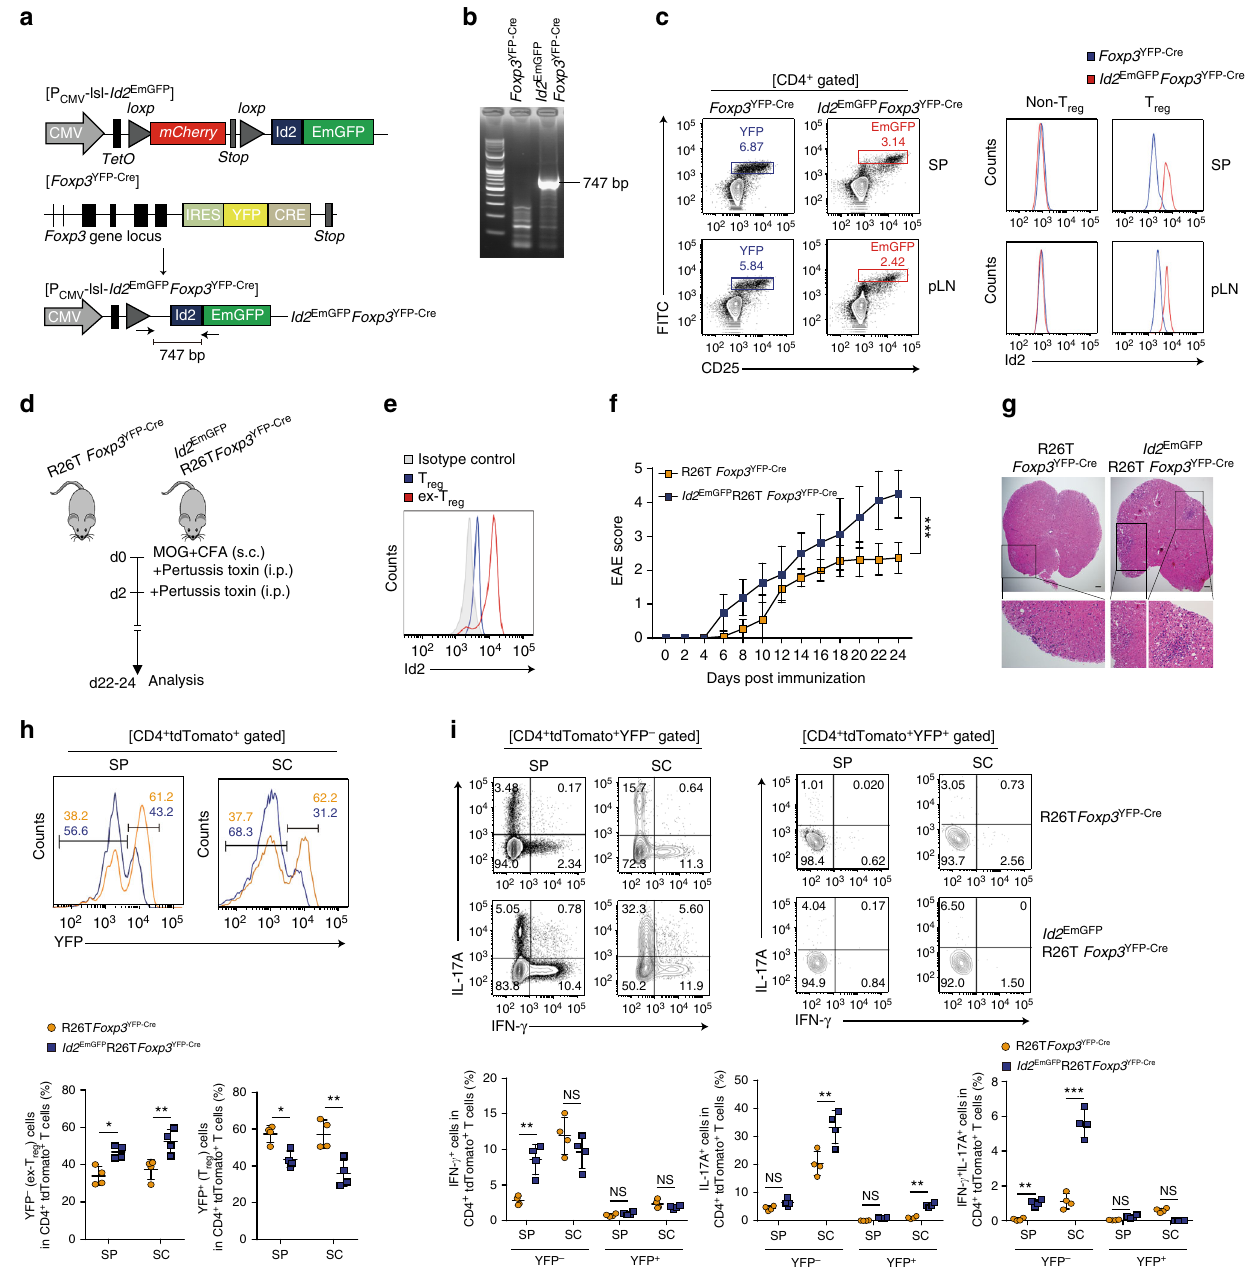
Fig. 3 Mice with T reg -speci fi c ectopic expression of Id2 displayed enhanced conversion to ex-Foxp3 T H 17 cells from T reg cells after induction of EAE. a Schematic representation the mouse model employed. Converging arrows in the lower panel indicate genotyping primers. b Genotyping PCR to detect the presence of Id2-EmGFP transgene in Id2 EmGFP Foxp3 YFP − Cre mice. c Flow cytometry analysis of YFP and EmGFP expression in CD4 + CD25 + T cells from spleen (SP) and peripheral lymph nodes (pLN) of Foxp3 YFP − Cre and Id2 EmGFP Foxp3 YFP − Cre mice (left panel). Id2 expression was assessed between non-T reg and T reg cells by intracellular staining (right panel). d Schematic of experimental EAE model. e Representative fl ow cytometry analysis of Id2 expression between tdTomato + YFP + (T reg ) and tdTomato + YFP − (ex-T reg ) cells in CD4 + T cells from 6 to 8 week-old R26T Foxp3 YFP − Cre mice on day 24 after induction of EAE. f Mean clinical scores in mice after induction of EAE (R26T Foxp3 YFP − Cre ; n = 12, Id2 EmGFP R26T Foxp3 YFP − Cre ; n = 9). g Representative Spinal Cord (SC) sections and hematoxylin and eosin (H&E) staining from EAE induced mice at day 24 after immunization (scale bar, 100 μ m). h Flow cytometry analysis and percentages of Foxp3 suf fi cient (YFP + ) and de fi cient (YFP − ) populations among CD4 + tdTomato + in SP and SC from R26T Foxp3 YFP − Cre and Id2 EmGFP R26T Foxp3 YFP − Cre mice at day 22 – 24 after induction of EAE. i Representative fl ow cytometry analysis and percentages of IFN- γ + , IL-17A + and IFN- γ + IL-17A + in CD4 + tdTomato + YFP − or CD4 + tdTomato + YFP + T cells in total SP and SC cells stimulated with phorbol myristate acetate (PMA) and ionomycin for 6 h. NS, not signi fi cant, *P < 0.05, **P < 0.005, ***P < 0.001 (Student ’ s t -test). All data are representative of two independent experiments (error bars,